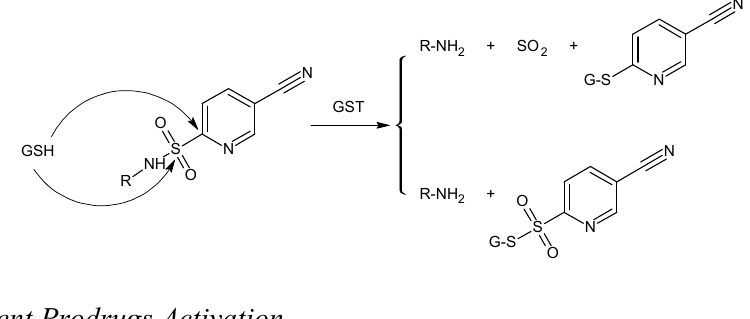
Figure 5. Proposed mechanistic pathway for glutathione transferase (GST)/GSH-mediated sulfonamide cleavage.